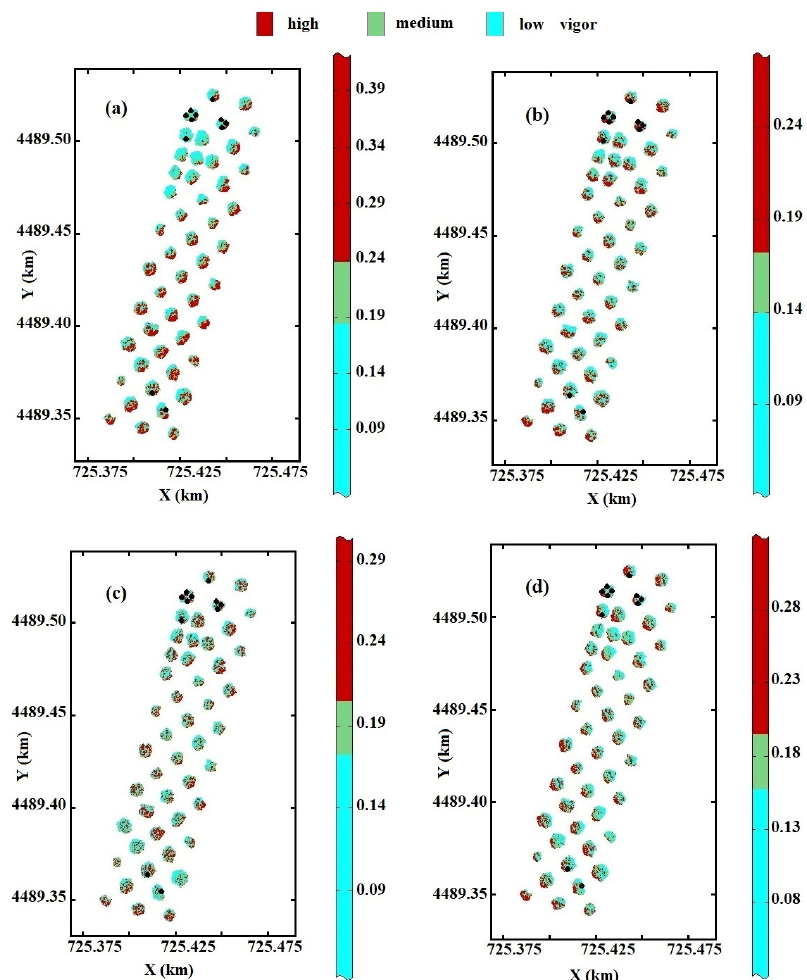
Figure 7. Maps of red-edge reflectance at the four dates: 20 September 2017 ( a ); 9th March 2018 ( b ); 20 June 2018 ( c ); 2 August 2019 ( d ) with double color scale: qualitative and quantitative (3 isofrequecy classes) classes. Black dots correspond to the crown sector classified by the operator as infected on 20 September 2017.